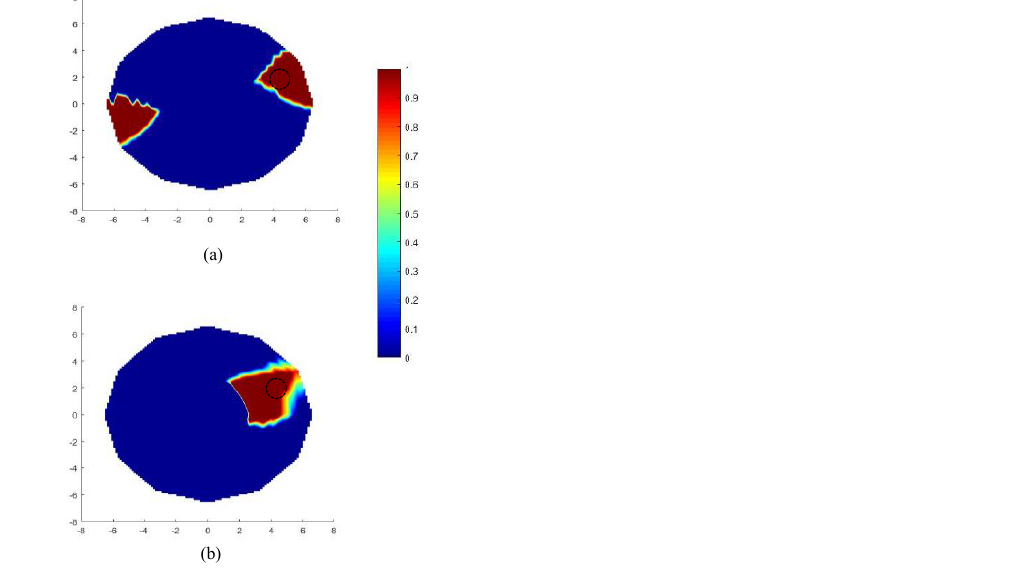
Figure 3. An example reconstructed image on xy (z = 0) plane: ( a ) image without metallic rod (ambiguity present), ( b ) image with metallic rod inserted (no ambiguity). Dotted circle shows the actual position of the anomaly.